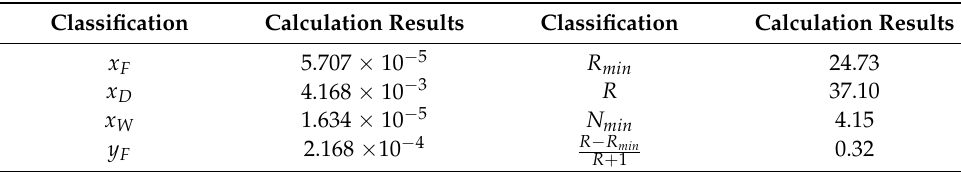
Table 1. Some calculation results for the theoretical plate